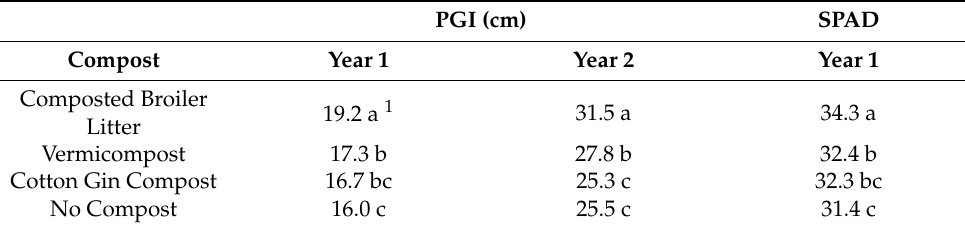
Table 3. Effects of pre-plant compost incorporation on plant growth index (PGI) and leaf SPAD readings of zinnia “Benary’s Giant Mix” grown in a high tunnel. Data were taken 26 days after transplanting in both